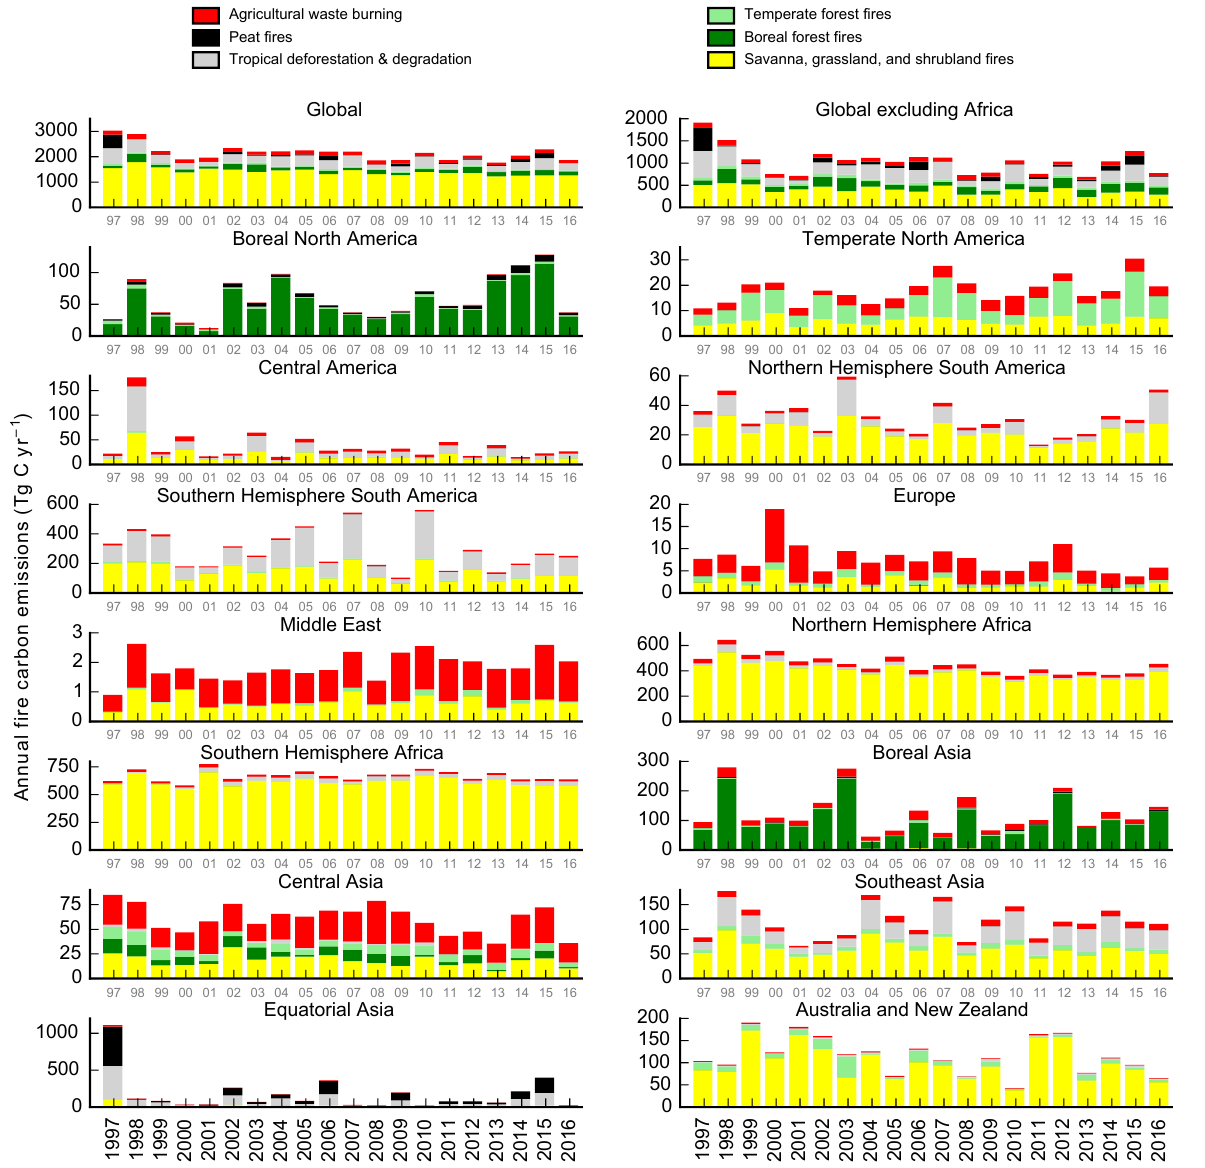
Figure 9. GFED4s annual fire carbon emissions for various regions and